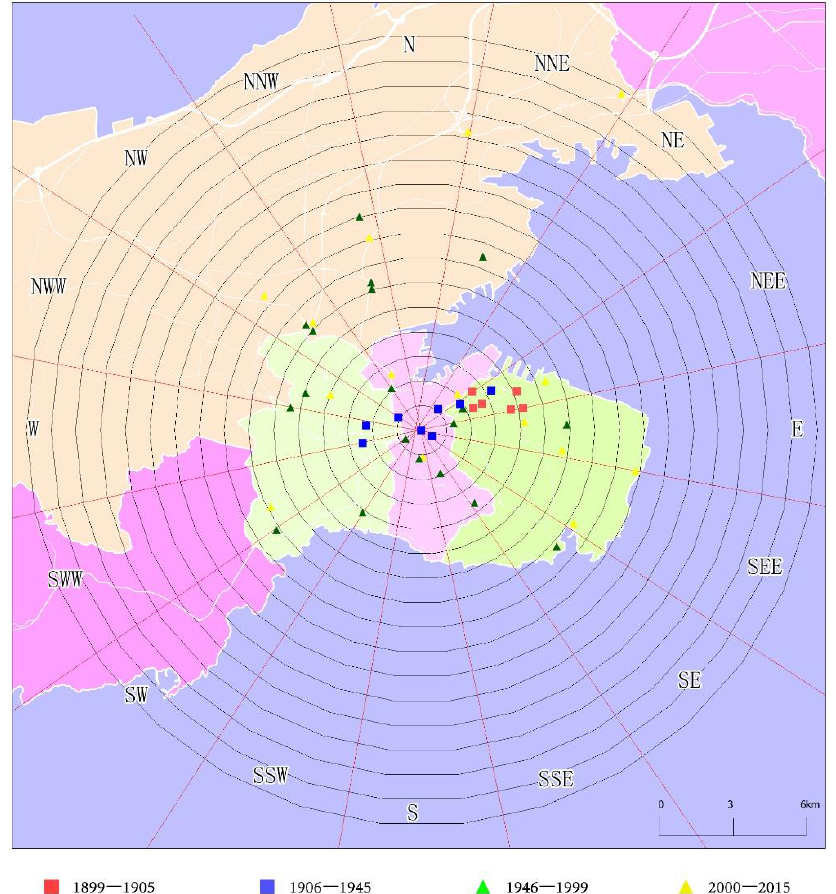
Figure 3. Differences in the spatial distributions of city squares.